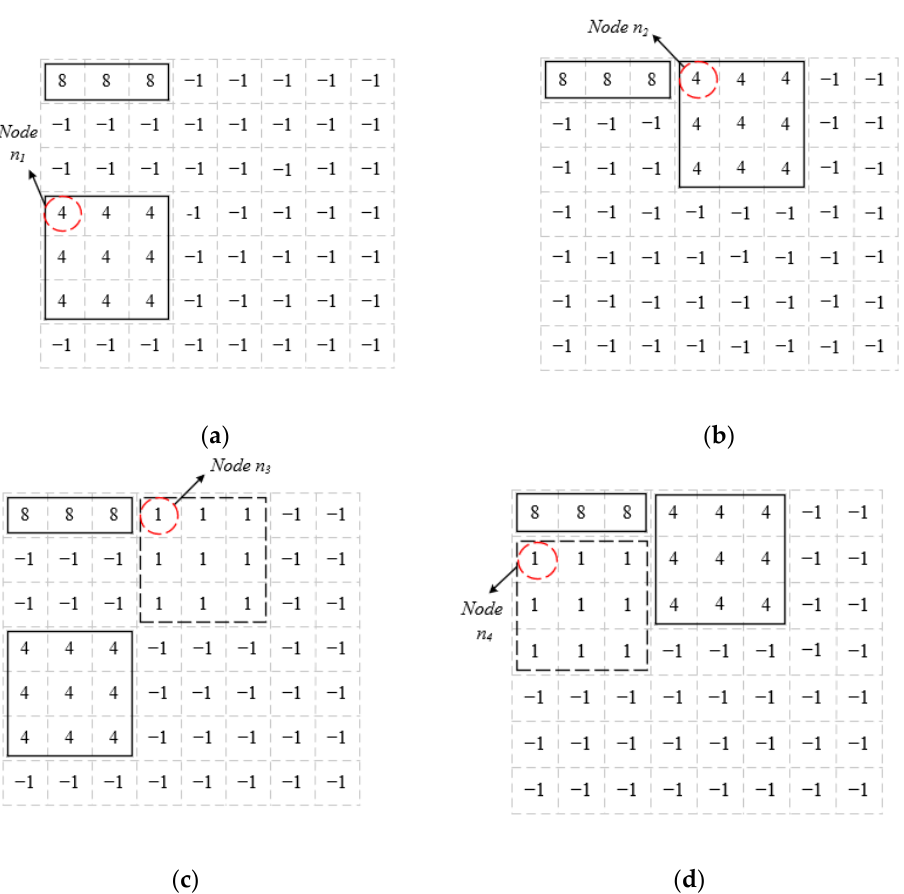
Figure 6. ( a , b ) An example of nodes having the same heuristic information. ( c , d ) Secondary exploration method to map the next chiplet.